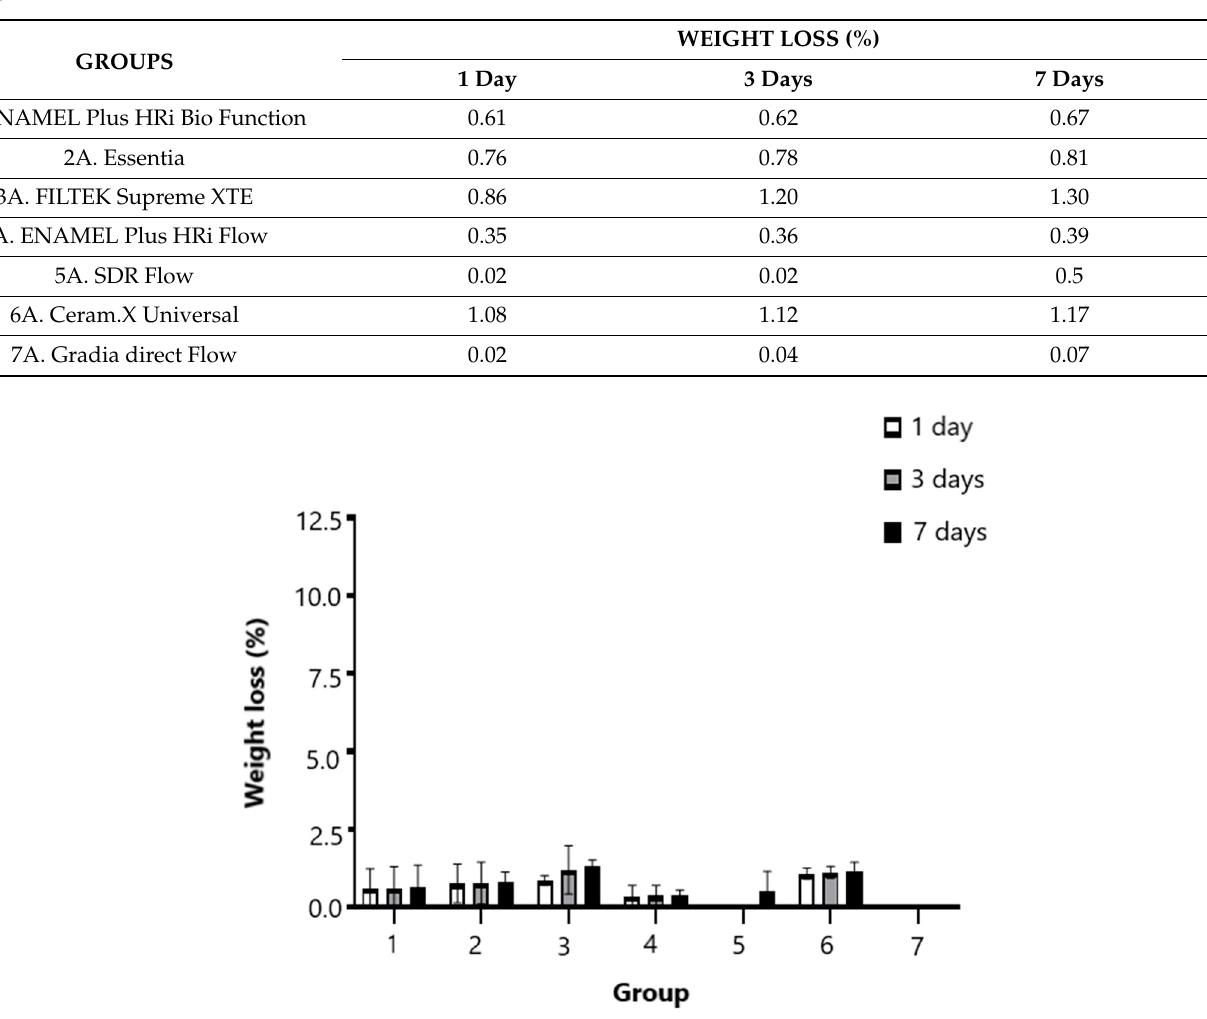
Table 3. Weight loss of composite resins after 1, 3, and 7 day of acid challenge: data are expressed as medium percentage of weight loss.